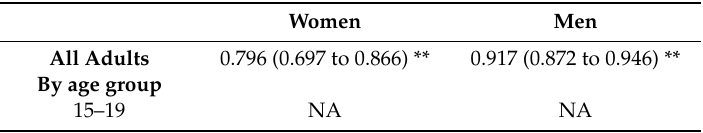
Figure 2. Estimated (red) and registered (blue) ACM mortality rates per 100,000 and alcohol per capita consumption (APC) over selected age groups and by sex (column) for most recent available data of n = 77 countries; solid line denotes same-year APC (first row) and dashed line denotes 5-year (second row) and 10-year lagged APC (third row). Table 2. Correlation of registered and estimated ACM crude mortality rates (deaths per 100,000 people) for all adults and by sex and age